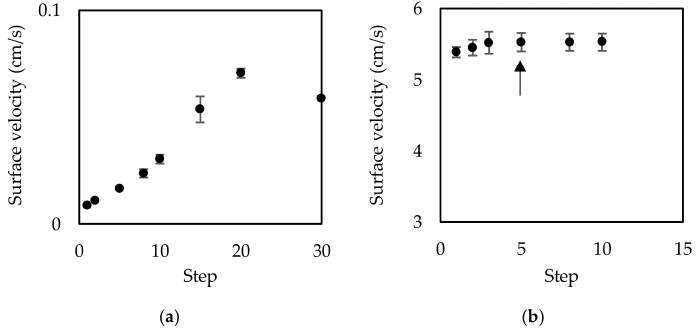
Figure 7. Sensitivity of the time-mean surface sediment velocity to the step value for ( a ) low and ( b ) high sediment feeding rate. In ( a ), uncertainty bars are displayed only if larger than the marker size (threshold value for display = 0.002 cm/s). The arrow indicates a measurement that is further explored in Figure